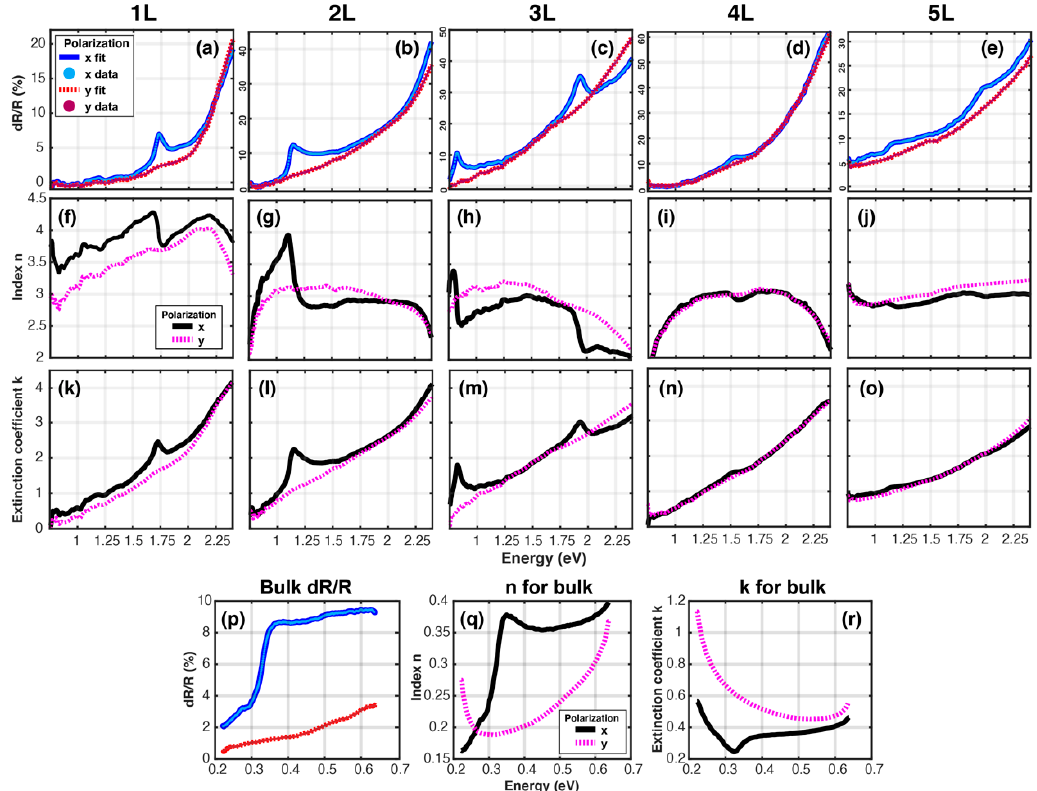
Figure 2. Complex index of refraction: results of fitting reflectance contrast dR / R data for 1–5 L and bulk BP, taken from Li. et al. [23] using the constrained Kramers–Kronig analysis (CKKA) method. First row ( a – e ): polarization-selective reflectance contrast dR / R (1 − R sample / R ref ) data, with constrained Kramers–Kronig analysis and transfer matrix method (CKKA + TMM) fits. Second row ( f – j ): real